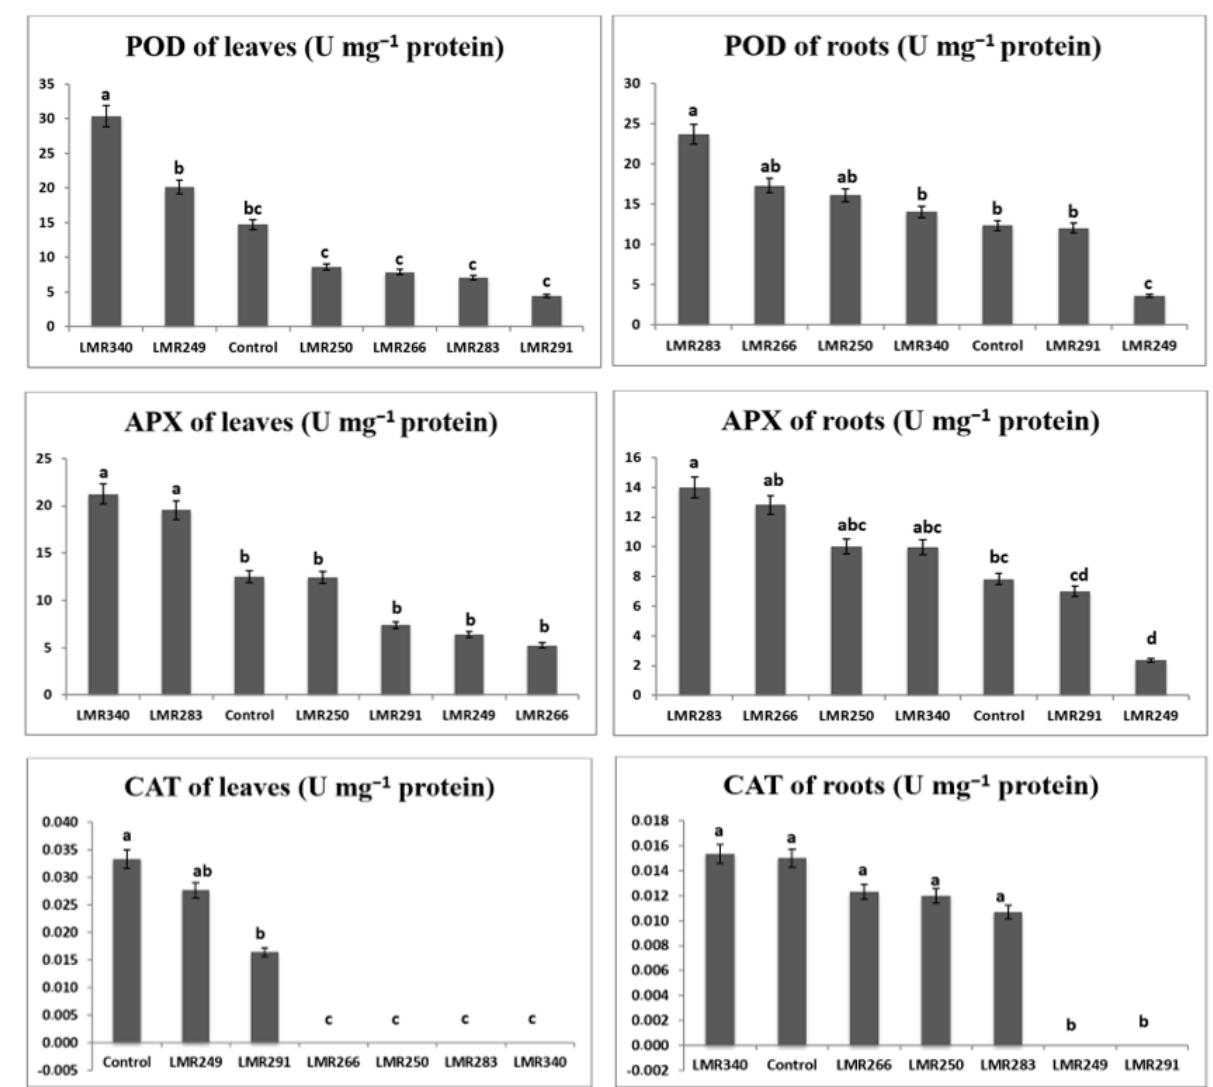
Figure 3. Changes in antioxidant enzymes in roots and leaves of Sulla plants 100 days after bacterial inoculation. All the values are means of 4 replicates. One-way ANOVA was performed to determine the influence of inoculated bacteria on antioxidant enzymes of plants growing in sterilized sand. Means for the different treatments with different letters are significantly different from each other ( p < 0.05) according to the Duncan test.